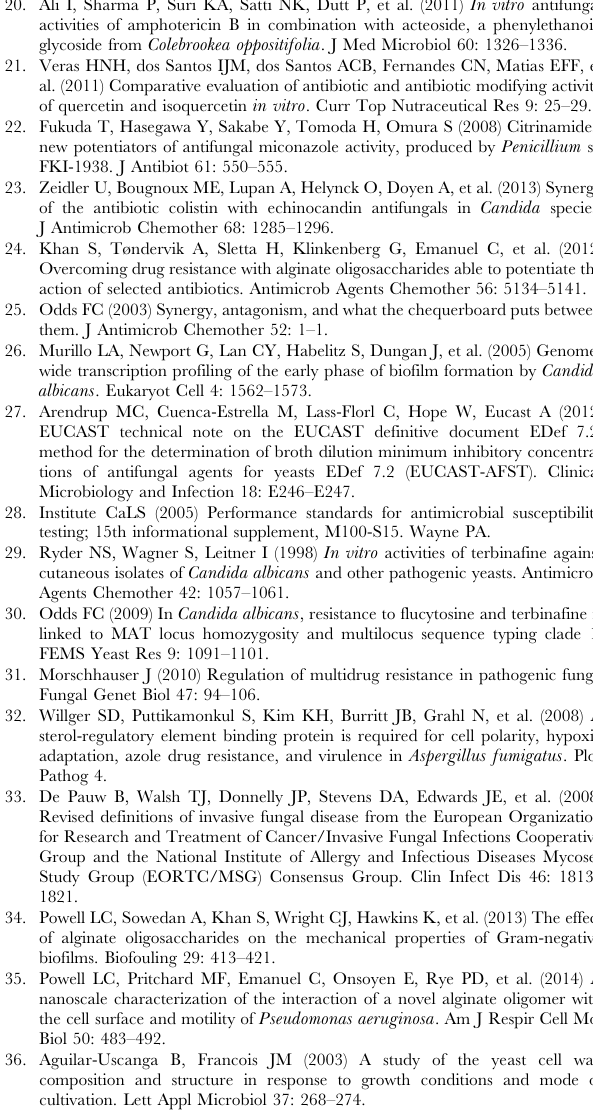
(TIF) Figure S3 Mean surface roughness expressed as (Ra) 6 standard error. *indicates significantly different from the control. FLC, fluconazole.